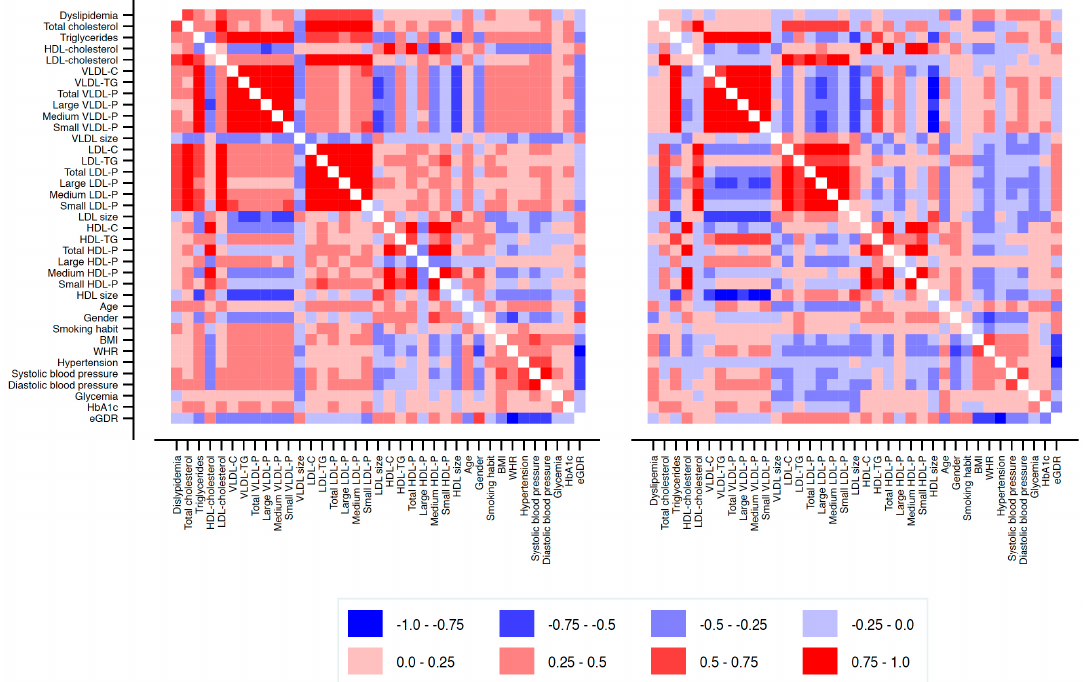
Figure 1. Correlation heat map of the association between NMR-assessed lipoprotein subclass 254 profiles and clinical variables in healthy participants (left panel) and in participants with T1DM 255 (right panel). HDL: high-density lipoprotein; LDL low-density lipoprotein; VLDL: very-low-density 256 lipoprotein; VLDL-C: cholesterol content in VLDL; VLDL-TG: triglyceride content in VLDL; VLDL-P: 257 VLDL particles; LDL-C: cholesterol content in LDL; LDL-TG: triglyceride content in LDL; LDL-P: 258 LDL particles; HDL-C: cholesterol content in HDL; HDL-TG: triglyceride content in HDL; HDL-P: 259 HDL particles; BMI: body mass index; WHR: waist-to-hip ratio; eGDR: estimated glucose disposal 260 rate. 261